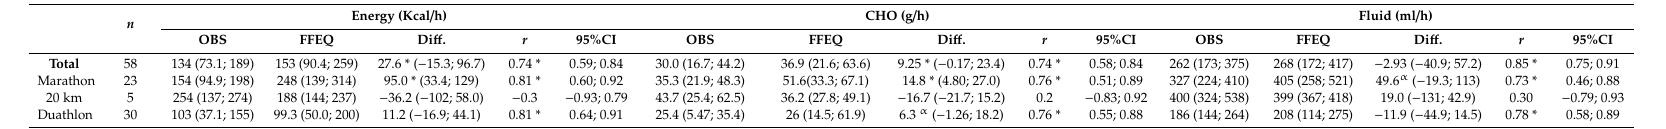
Table 3. Median and interquartile range (IQR) of observed and FFEQ-measured energy (kcal), carbohydrate (CHO), and fluid (FLU) intake per hour, di ff erence, and correlations with a 95% CI between FFEQ-measured and observed intake for all participants and per